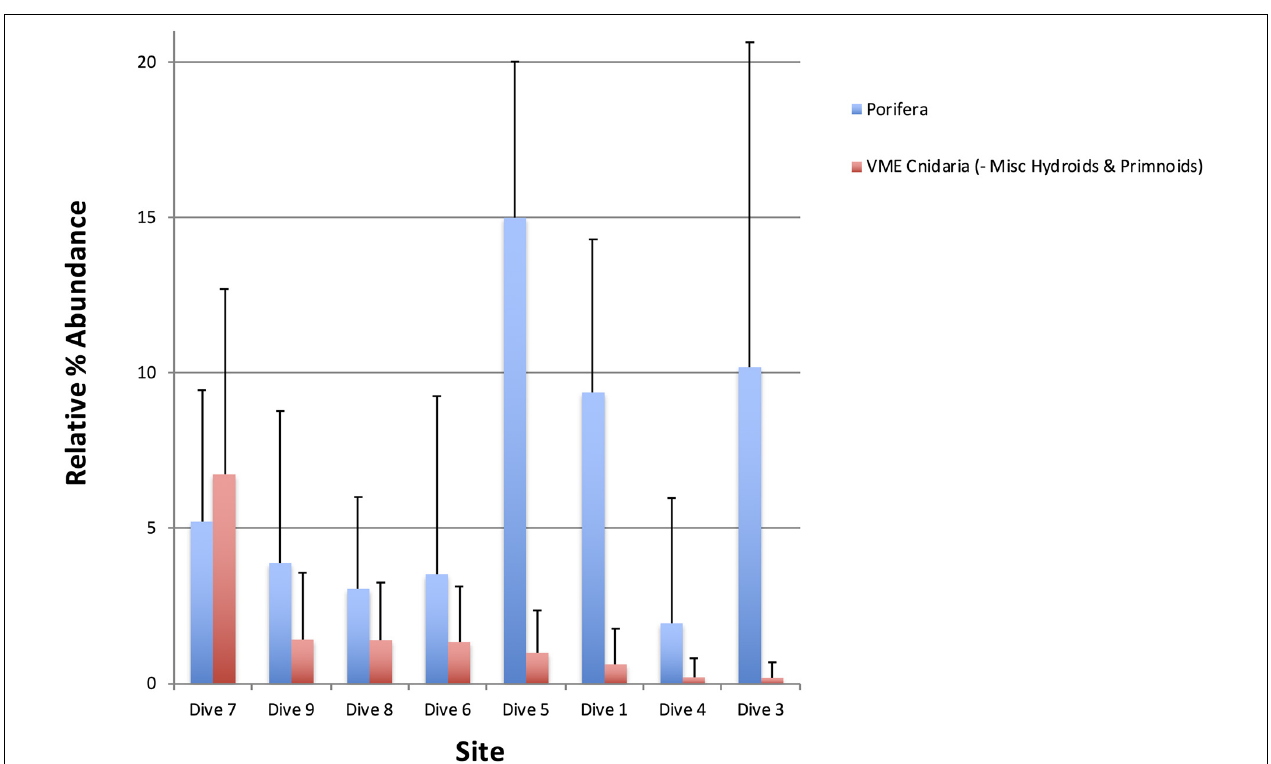
FIGURE 8 | Percentage abundance of all VME indicator Cnidaria taxa excluding miscellaneous hydroids and primnoids (red), which were excluded based on the fact that they are positively correlated with Porifera (blue). Dive site 7 off Lecointe Island in the Gerlache Strait supports significantly more coral taxa than all other sites.